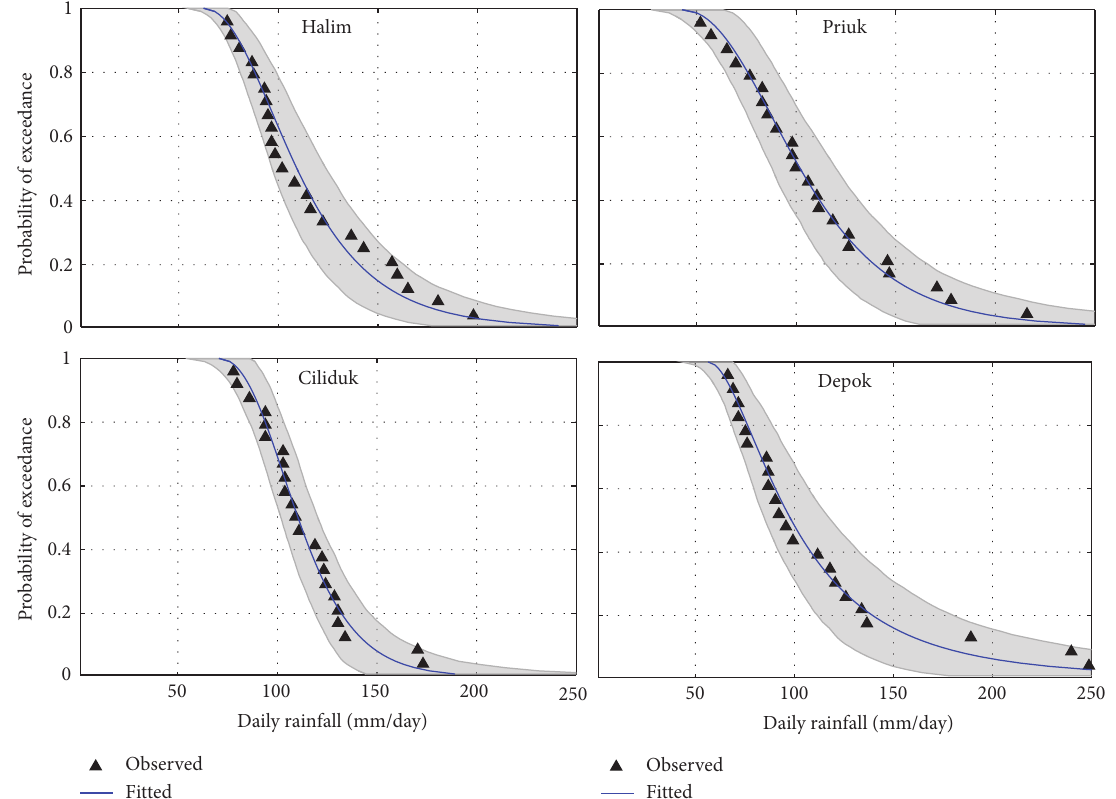
Figure 4: Annual maximum of daily rainfall fitted with LP3. The shaded region shows 95% confidence interval.